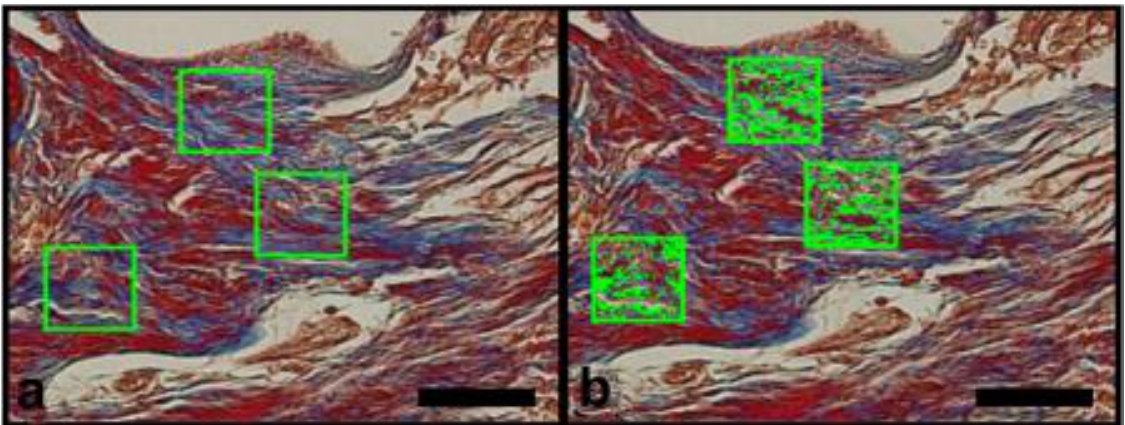
Figure 3. Photomicrographs of histomorphometric analysis, quantification of the area of interest of the sections stained with Masson’s trichrome (×40 magnification) (100 µm scale bar). ( a ) Green square areas limited the quantification sites randomly selected. ( b ) Green dotted area inside green square indicates the Image Pro Plus 7.0 software identification of the bluish staining.